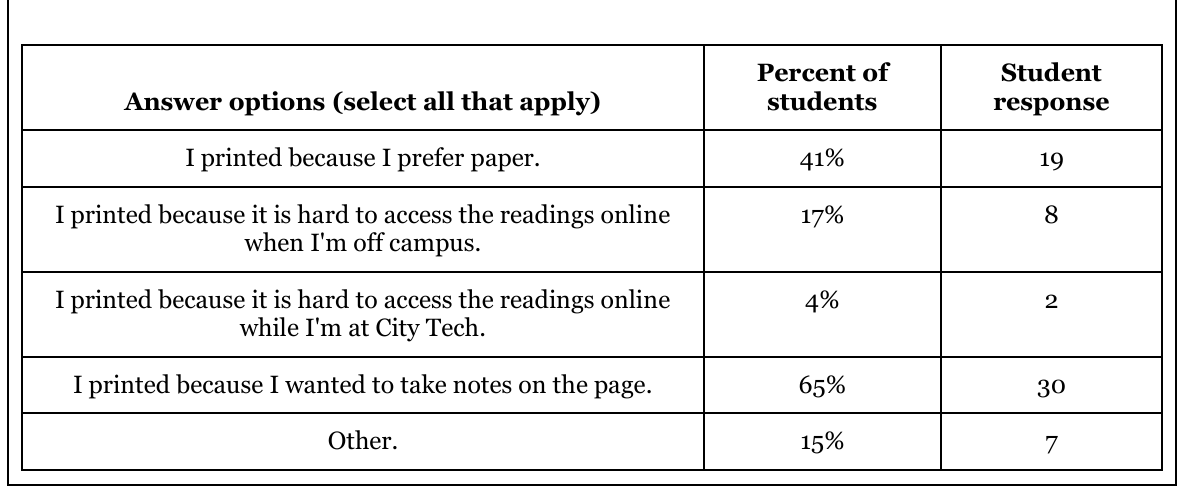
Distribution of Student Responses to the Question: “If You Printed Out Any Readings for the Course, Why Did You Print?”